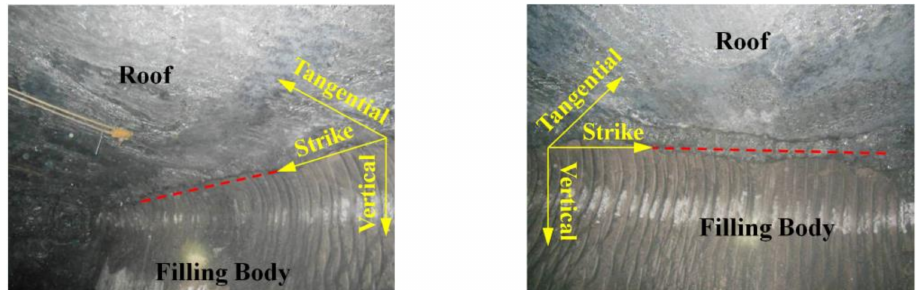
Figure 15. Situations of filling bodies connected to the roof in mining roadways (MRs). Reprint with permission [24]; Copyright 2018, Journal of China coal